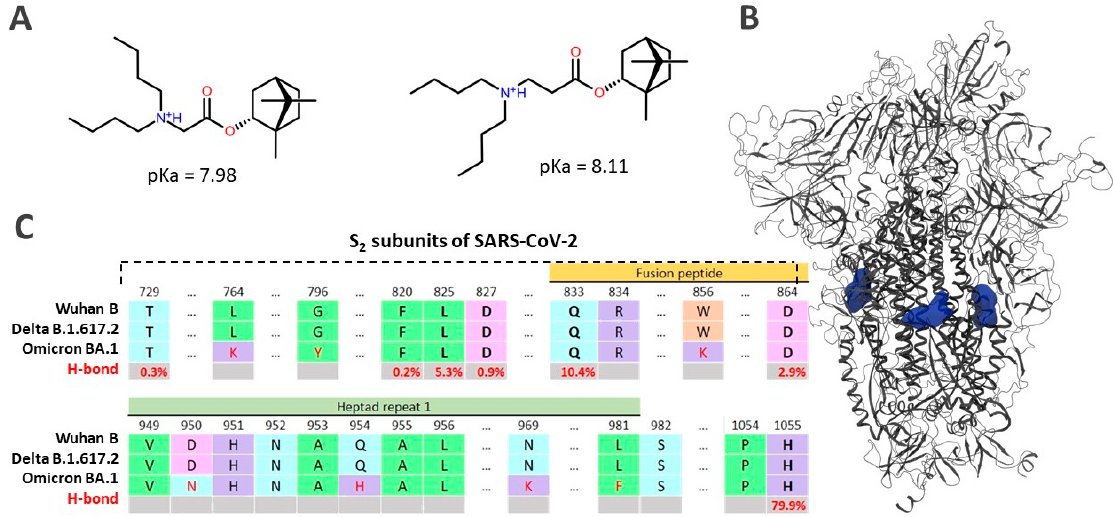
Figure 8. ( A )—is the result of the estimation of the acidity constant of the leader compounds by quantum chemistry; ( B )—is the weighted atomic population map of compound 21 based on the results of molecular dynamic simulations; ( C )—is the comparison of a number of amino acid residues of part S2 of SARS-CoV-2 of various strains, and replacements are shown in red font; H-bond is the frequency of formation (in %) of hydrogen bonds between ligand atoms and amino acids.